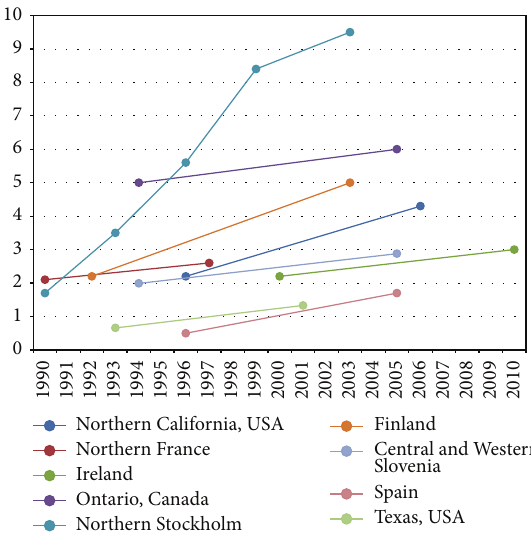
Figure 1: Incidence trends in pediatric Crohn’s disease from 1990 to